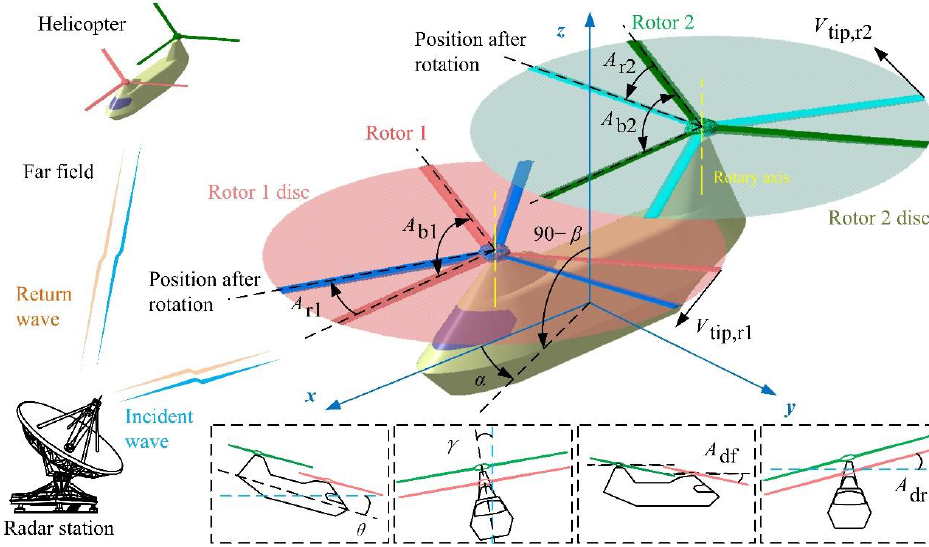
Figure 1. Schematic diagram of dynamic electromagnetic scattering of the tandem helicopter.